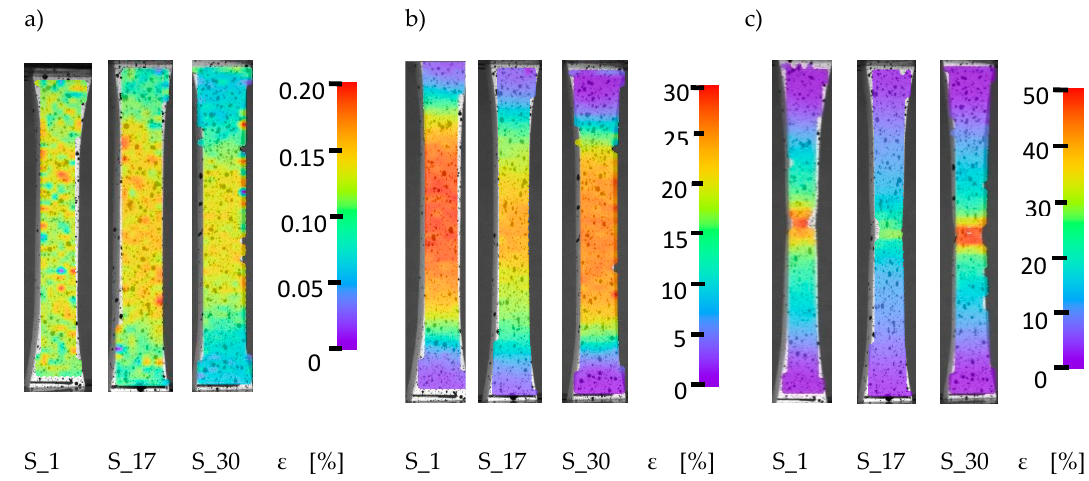
Figure 13. Strain distribution during monotonic tensile tests: ( a ) yield strength, ( b ) ultimate tensile strength, and ( c ) breaking strength.